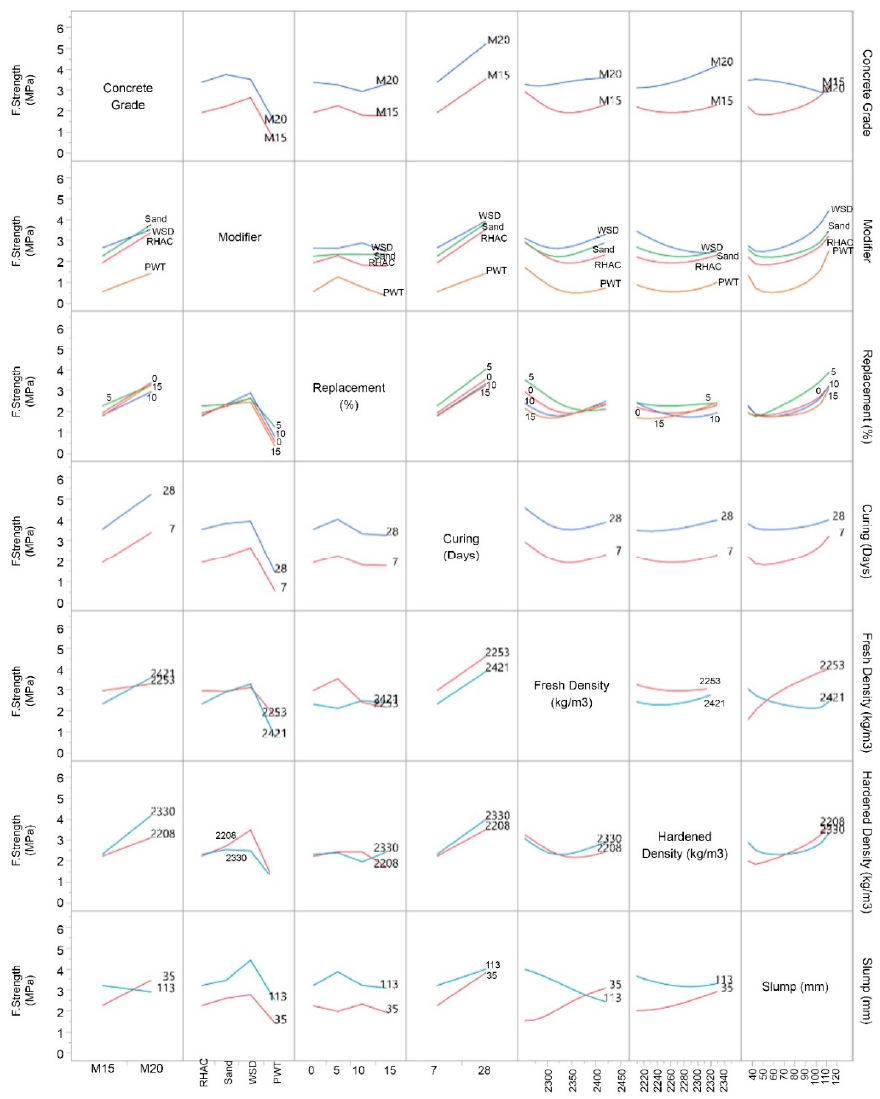
Figure 12. Flexure strength interaction profile.